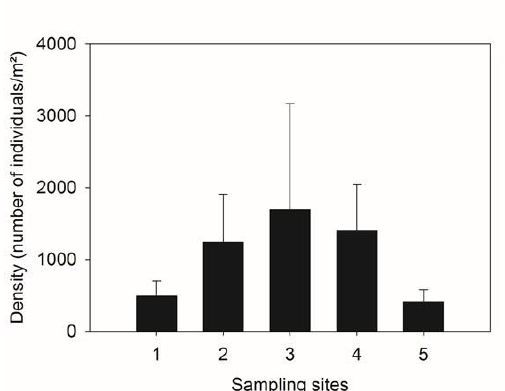
Figure 3. Mean densities (+ 1 standard deviation) of Corbicula fluminea in each sampling site at Poxim-Açu